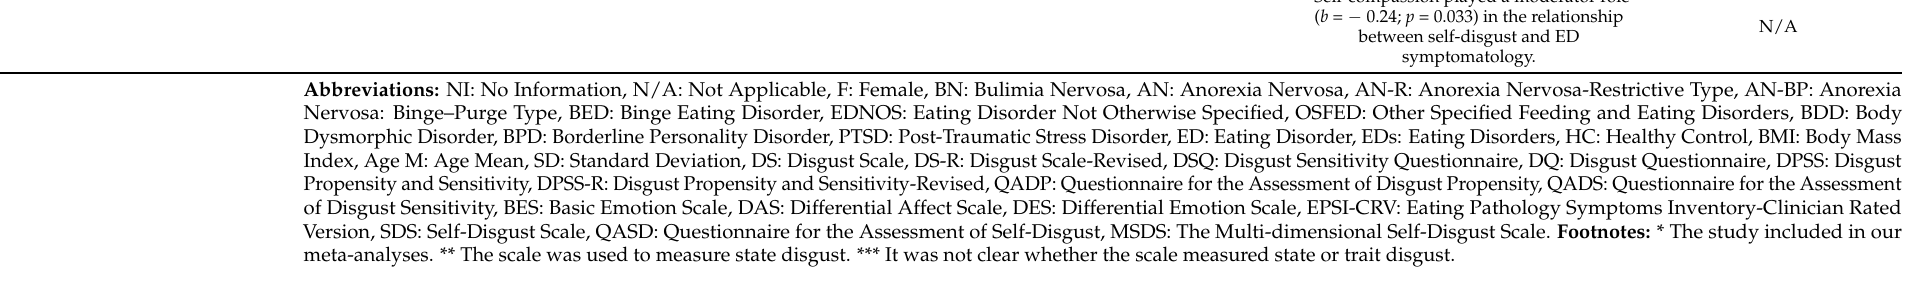
Table 2. A summary of studies using stimuli to trigger